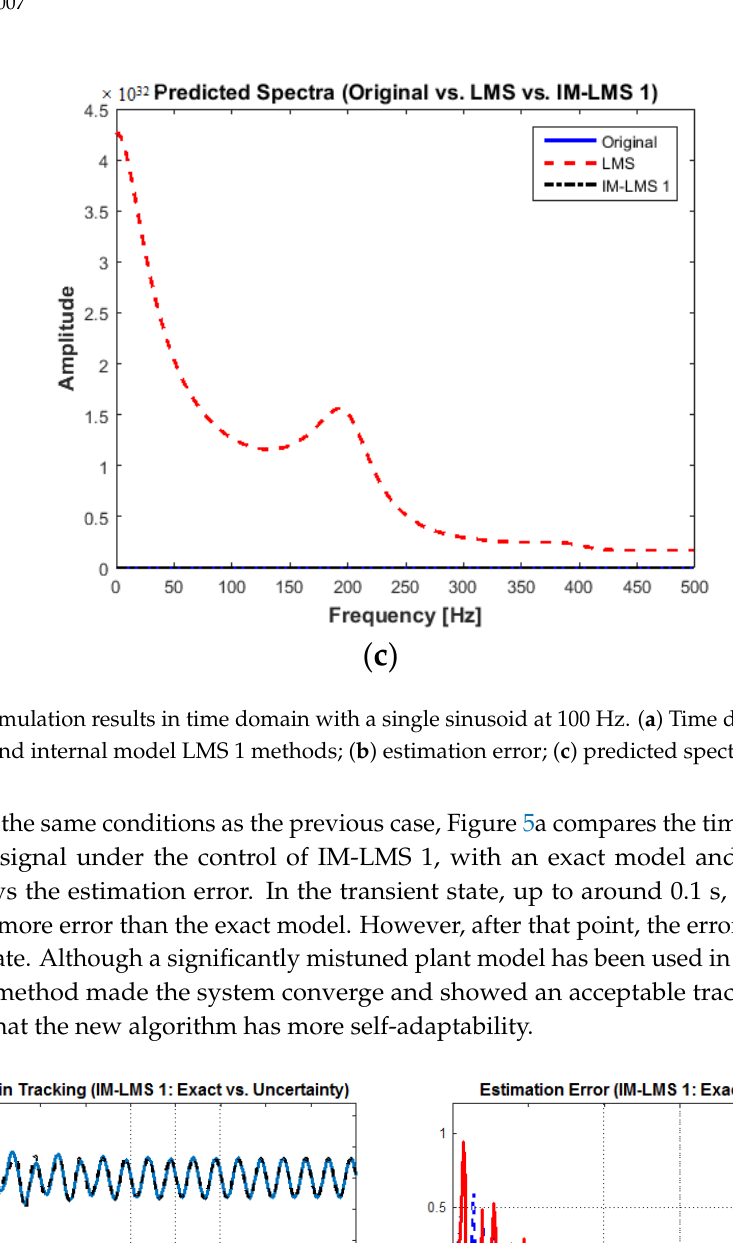
Figure 4. Simulation results in time domain with a single sinusoid at 100 Hz. ( a ) Time domain tracking with LMS and internal model LMS 1 methods; ( b ) estimation error; ( c ) predicted spectra.